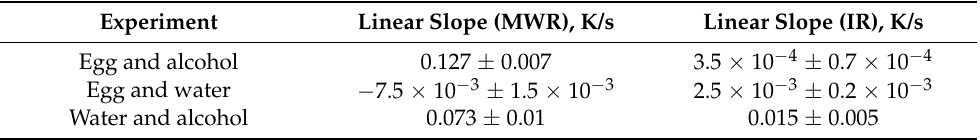
Table 1. Rate constants.